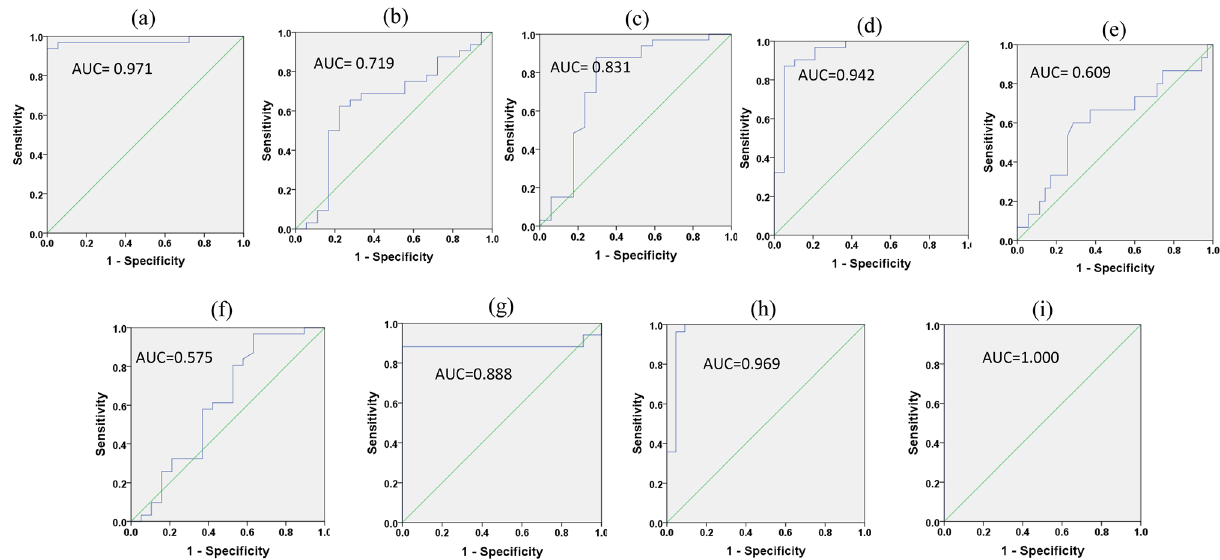
Figure 3. Receiver operating characteristics (ROC) plots of miRNA expression in urine sample of cervical cancer patients. ROC plots evaluating diagnostic potential of ( a ) miR-21-5p, ( b ) miR-155-5p, ( c ) miR-199a-5p, ( d ) combined ROC plots of three upregulated miRNAs (miR-21-5p, miR-155-5p, and miR-199a-5p), ( e ) miR- 218-5p, ( f ) miR-145-5p, ( g ) miR-34a-5p, ( h ) combined ROC plots of three downregulated miRNAs (miR- 218-5p, miR34a-5p, and miR-145-5p), and (l) combined ROC plots of all six